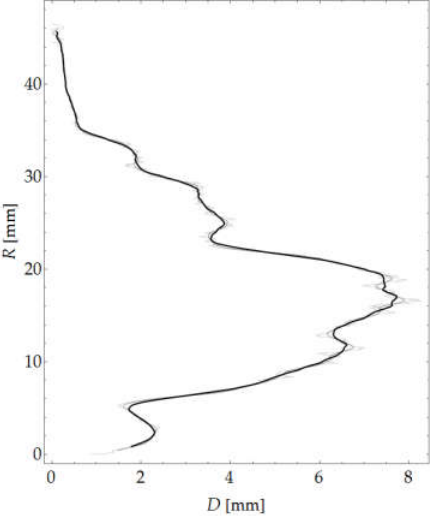
Figure 16. Mean aggregate size versus coordinate R.